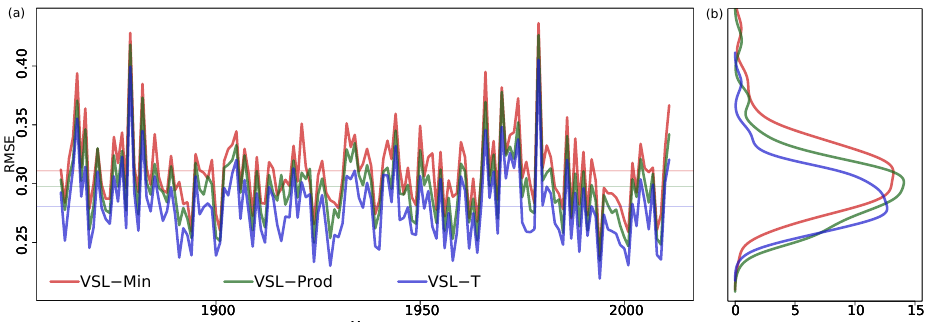
Figure 7. Global near-surface temperature RMSE for the off-line analysis of the ensemble runs constrained by VSL-Min (red), VSL-Prod (green) and VSL-T (blue) pseudo-TRW observations. Climatological soil moisture is used to drive the VSL model. Horizontal lines represent the mean values. Panel (b) shows the histograms of the time series.